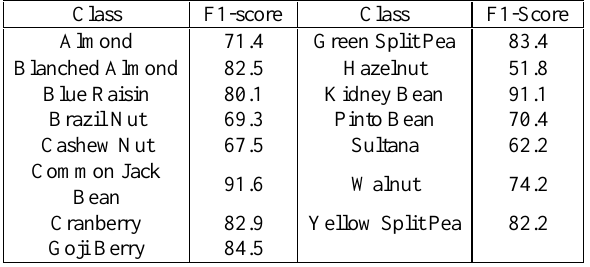
Table 3. F1-scores for the classification results of the Cubert dataset with the CNN of Figure 3.